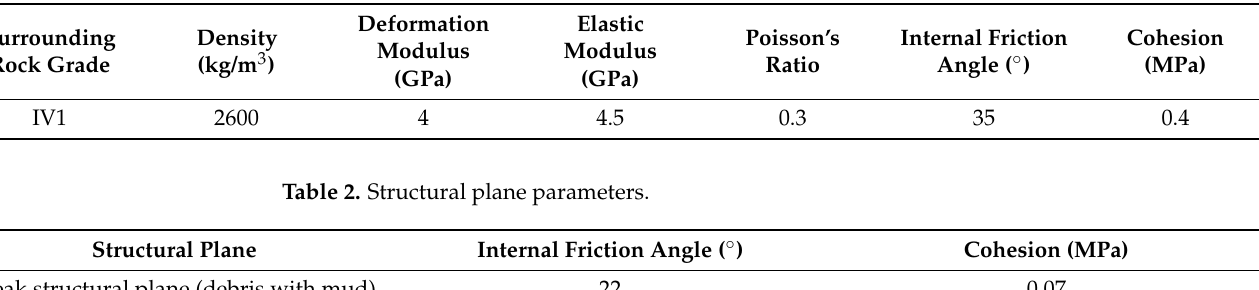
Figure 10. The 3D numerical model. ( a ) Complete model; ( b ) half of the model. Table 1. Surrounding rock parameters.